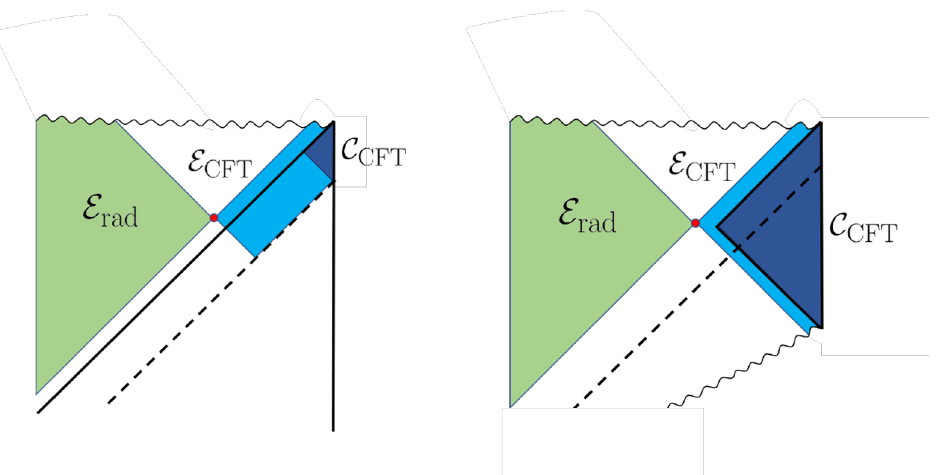
Figure 5. Because the absorbing boundary conditions are only deterministic when evolving for- wards in time, the domain of dependence of the boundary is the future boundary. The entanglement wedge E CFT of the CFT (light blue) contains the causal wedge C CFT (dark blue). When time is reversed using standard re(cid:13)ective boundary conditions, the entanglement wedge still contains the causal wedge because the backreaction on the geometry creates a white